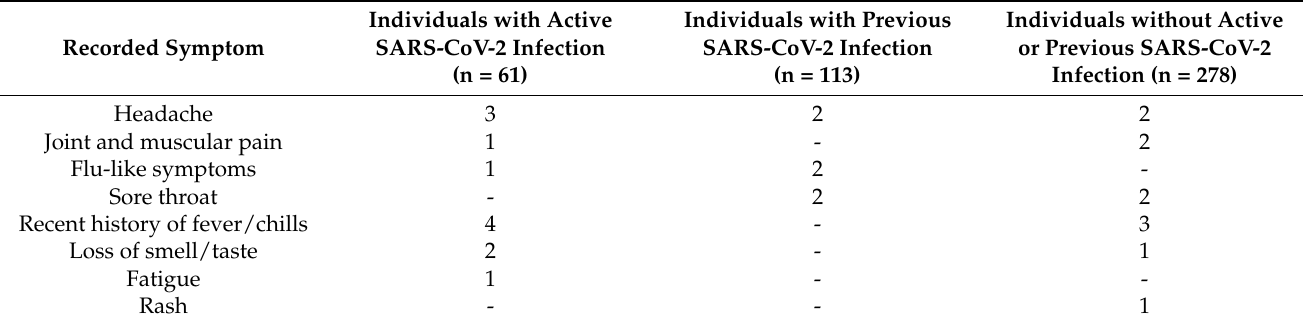
Only absolute numbers are presented. Statistical analysis was not performed as medical history had not been systematically